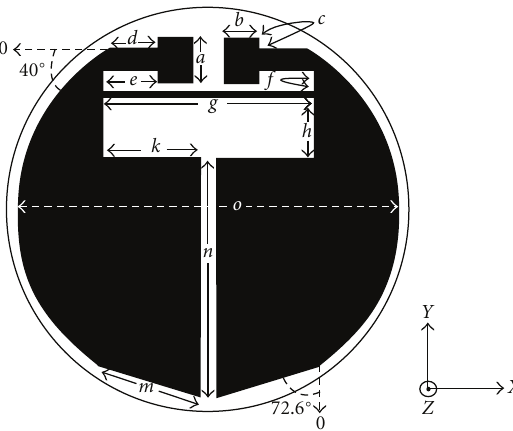
Figure 6: Geometrical parameters of the designed tag